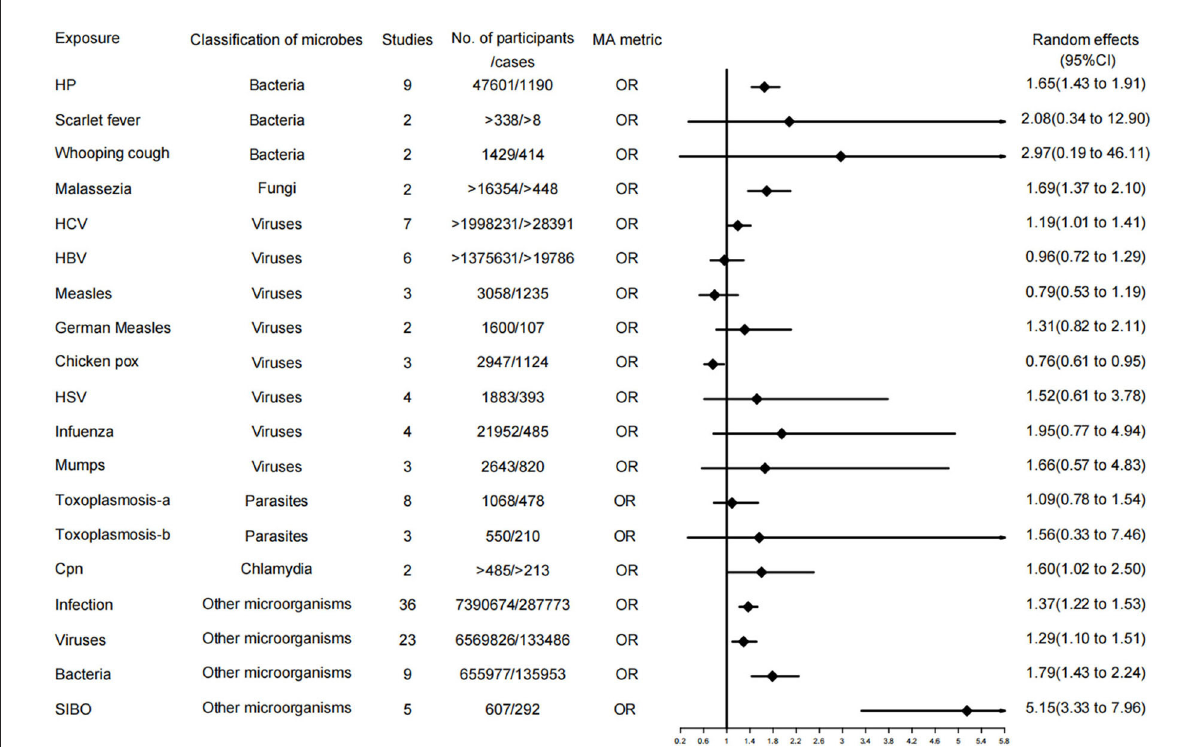
FIGURE2 Forest plots and the level of evidence of the association of microbiological factors with Parkinson’s disease. HP, Helicobacter pylori ; HCV, hepatitis C virus; HBV, hepatitis B virus; HSV, herpes virus; Toxoplasmosis-a, Toxoplasmosis (lgG antibodies); Toxoplasmosis-b, Toxoplasmosis (lgM antibodies); SIBO, Small intestinal bacterial